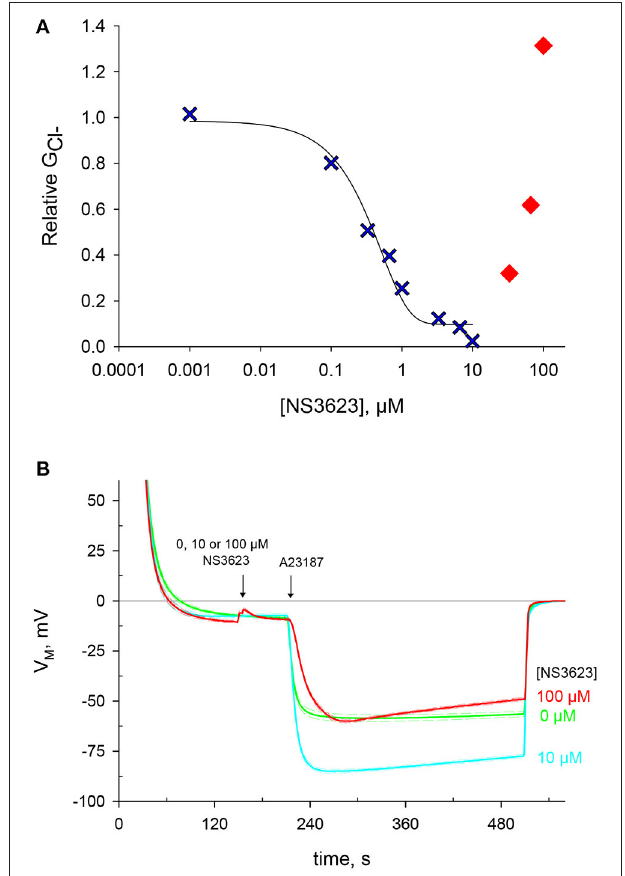
FIGURE 1 | NS3623 inhibits chloride conductance up to 10 µ M, another effect is unveiled at higher concentrations. (A) Dose-response curve of NS3623 effect on G Cl − , measured via valinomycin treatment. In blue, the experimental data can be fitted to a sigmoid curve up to 10 µ M. In red, at higher concentrations the points deviate from this curve. (B) Evolution of membrane potential from cells injected into normal Ringer solution at t = 30s with exposure to 0 µ M (green, mid trace, n = 22), 10 µ M (cyan, bottom trace, n = 12) or 100 µ M (red, top trace, n = 4) of NS3623 before hyperpolarization was triggered by 10 µ M A23187 addition. Dashed lines indicate ±